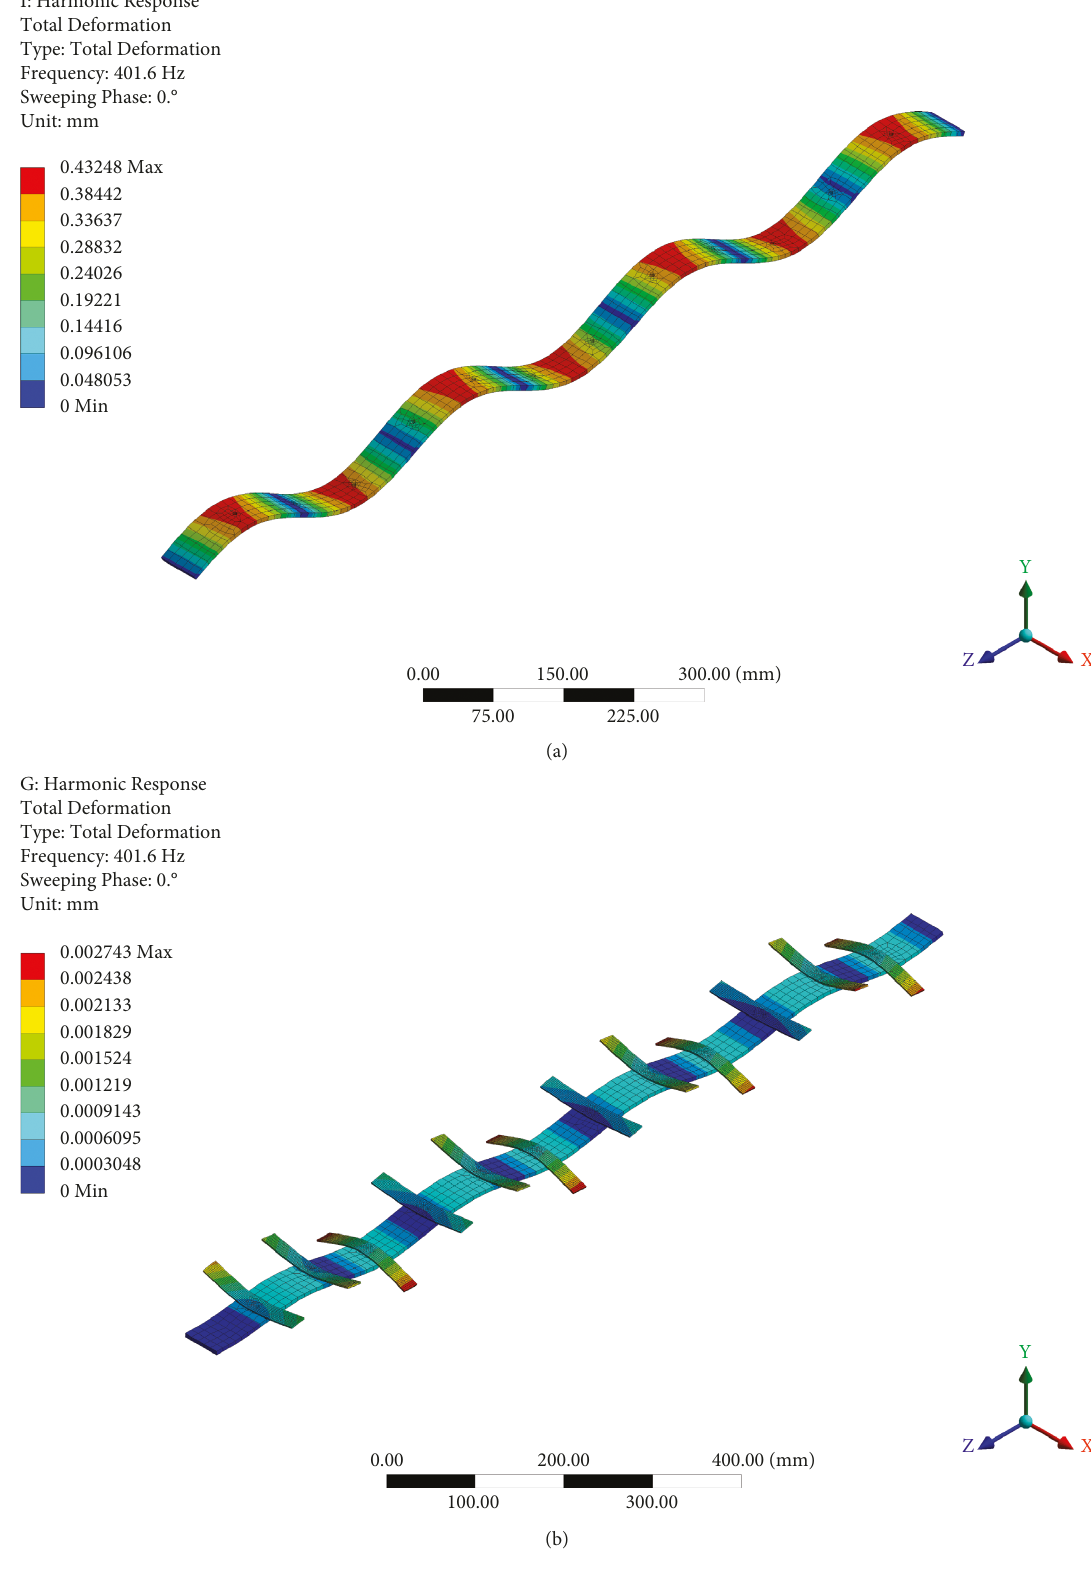
Figure 7: The displacement profiles of (a) the finite beam and (b) the finite beam with periodic arrays of Resonator1 (401.57Hz) at 401.6